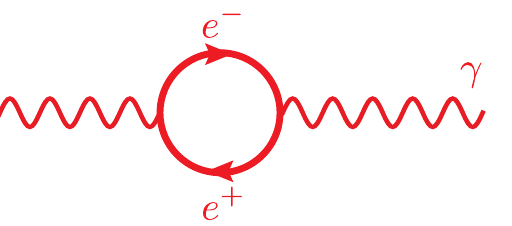
Figure 2. Vacuum polarization in the one-loop approximation. The wavy lines represent an electro- magnetic field ( γ ), while a vertex represents the interaction of the field with the fermions (electron– positron pair, e − e + ), represented by the loop.The arrows notify the momentum being opposite for particle (electron) and antiparticle (positron). The resulting polarization is maximal for a free electro- magnetic field, for which the angular frequency, ω = | k | c , with k the wave vector and c denoting the speed of